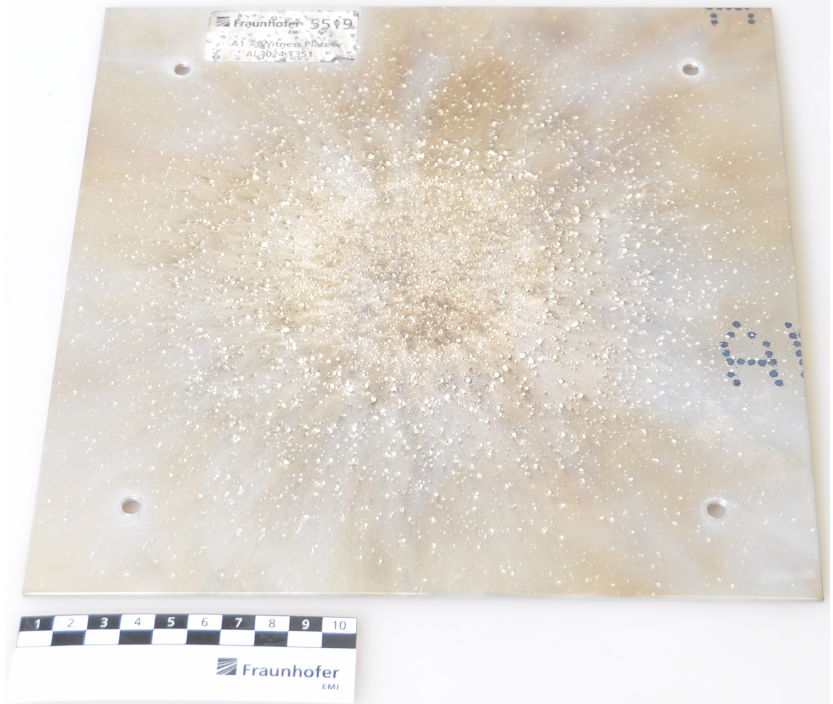
Figure 8. The witness plate from the experiment shown in Figure 6 contains many small impact craters left by the debris cloud fragments. The average crater has a diameter of approximately 1 mm, but there is no crater left by a large central fragment. Figure courtesy of Fraunhofer Ernst–Mach–Institut.